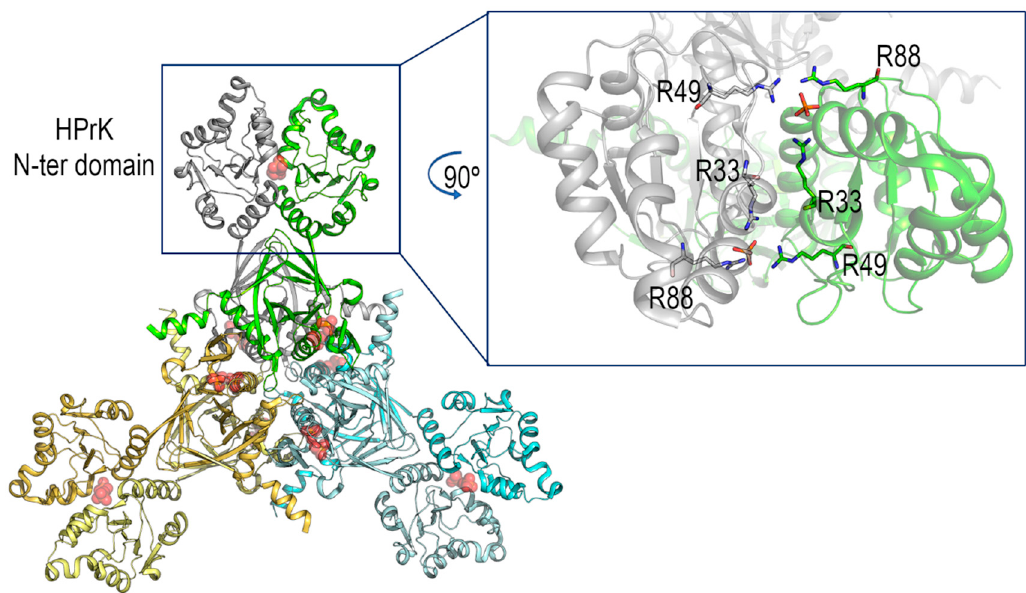
Figure 5. Structure of HPrK/P of Staphylococcus xylosus . (Left side) Hexamer of the HPrK/P from Staphylococcus xylosus (PDB entry 1KO7). The dimer in the asymmetric unit generates the hexamer through the symmetry operators. At the N-terminal domain of the HPrK/P, the interface between the dimer is stabilized by a salt bridge. (Right side) Detail of the salt bridge between the phosphate ions located at the interface and the arginine residues (shown in sticks). To facilitate the view of these interactions, the molecule has been rotated 90 °. The figure was produced with Pymol [39].